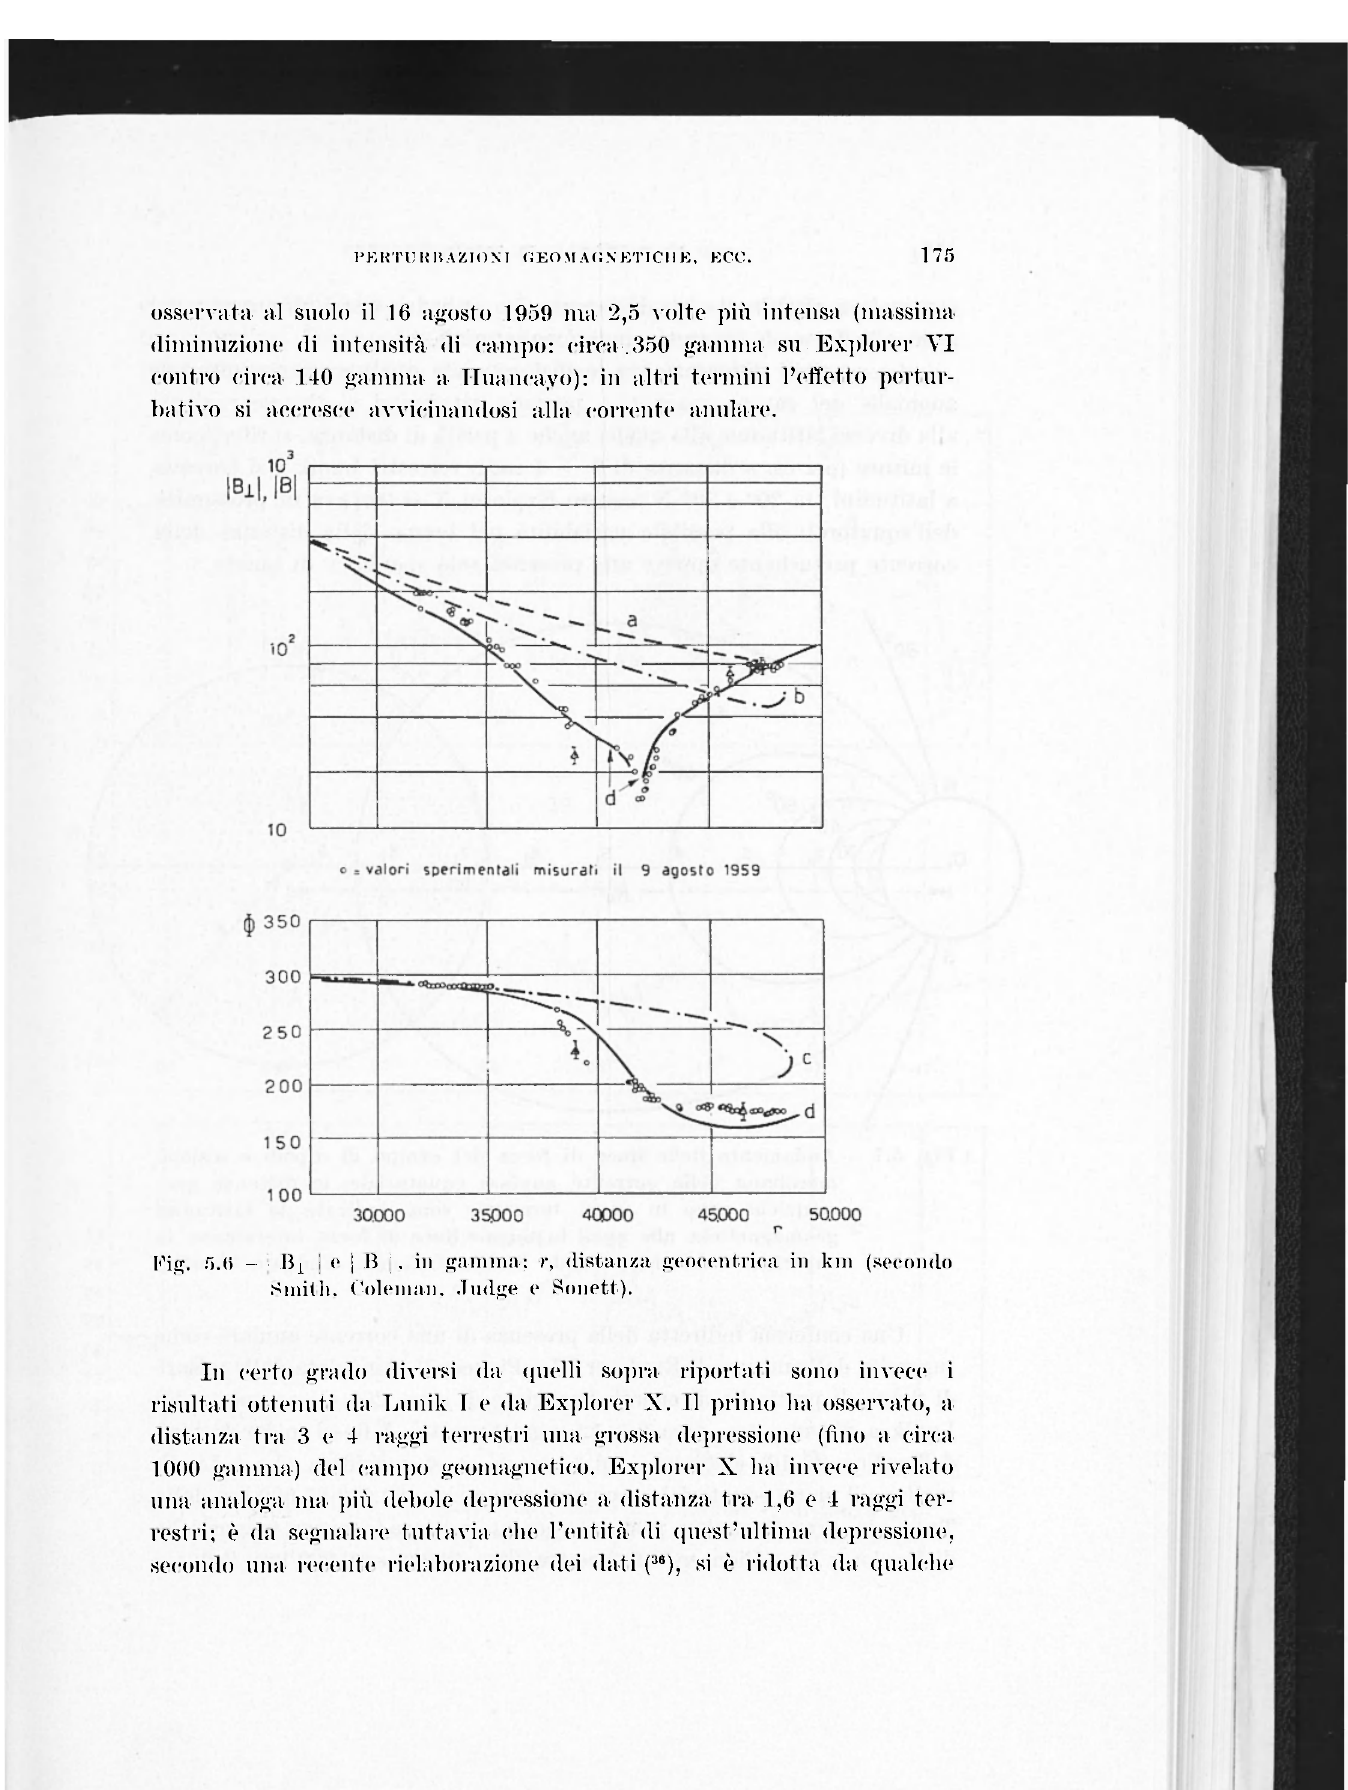
Fig. 5.6 • • Bj | e | B [, in gamma; r, distanza geocentrica in km (secondo Smith. Colenian, Judge e